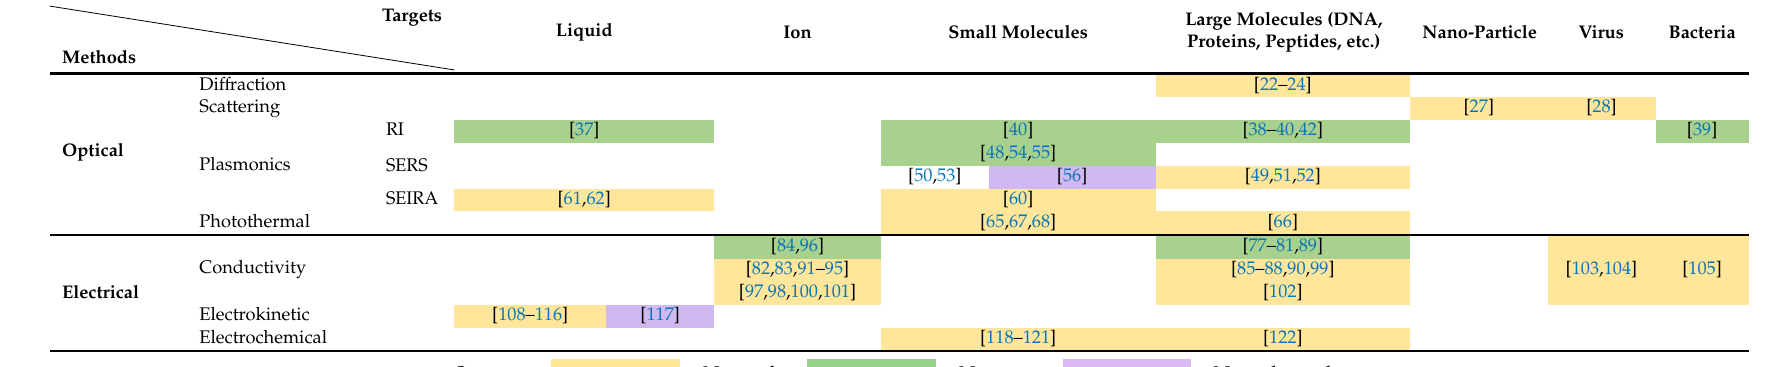
Table 1. Summary of label-free detection methods applicable to nanofluidics.